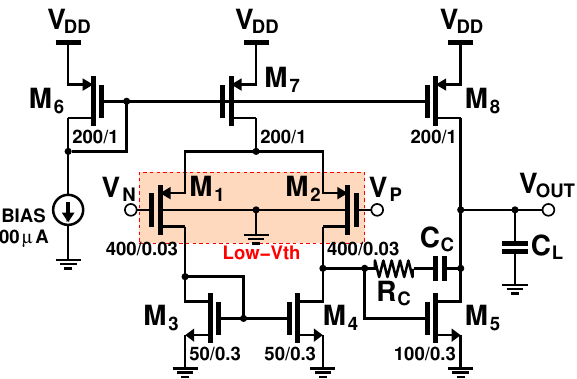
Figure 4. Circuit schematic of the implemented opamp for the sensor driver. The specified width/length are reported in µm for each MOSFET. Table 1. Specifications of the designed opamp obtained through circuit